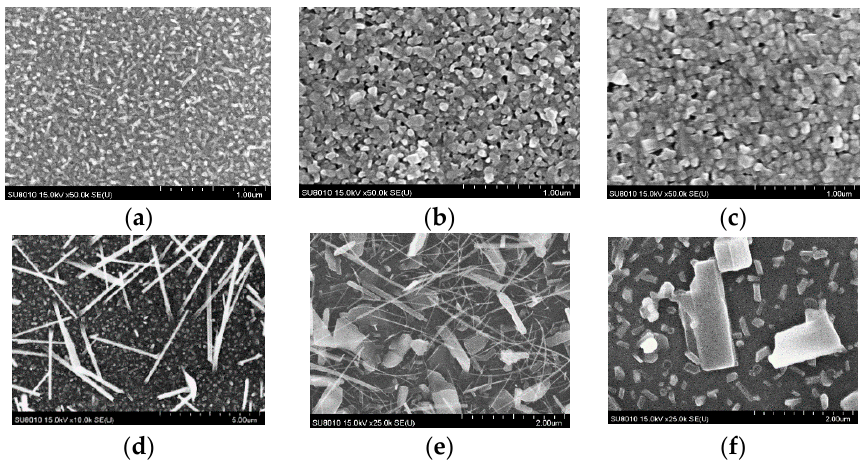
Figure 3. The top view topography of the Fe-doped WO 3 : ( a ) S1 sample–the surface of the film grown at T = 600 ◦ C, ( b ) the film annealed at T = 700 ◦ C, ( c ) the film annealed at T = 720 ◦ C, ( d ) the film annealed at T = 750 ◦ C, ( e ) S2 sample–the film grown at 720 ◦ C, ( f ) the film annealed at 750 ◦ C.